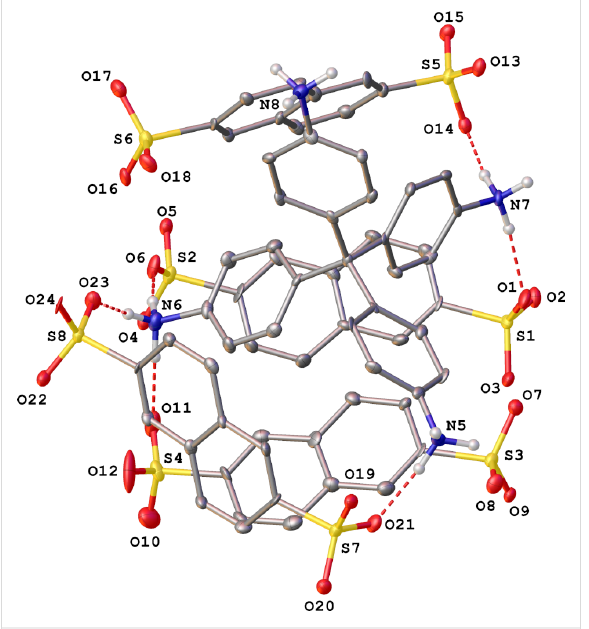
Figure 2: View of the crystal structure of F-1 ( F-1a’ phase), with repre- sentation of the atoms via thermal ellipsoids at a 30% probability level. The hydrogen atoms, except for those in NH groups, were omitted for clarity. Only the labels of symmetry-independent heteroatoms are shown.